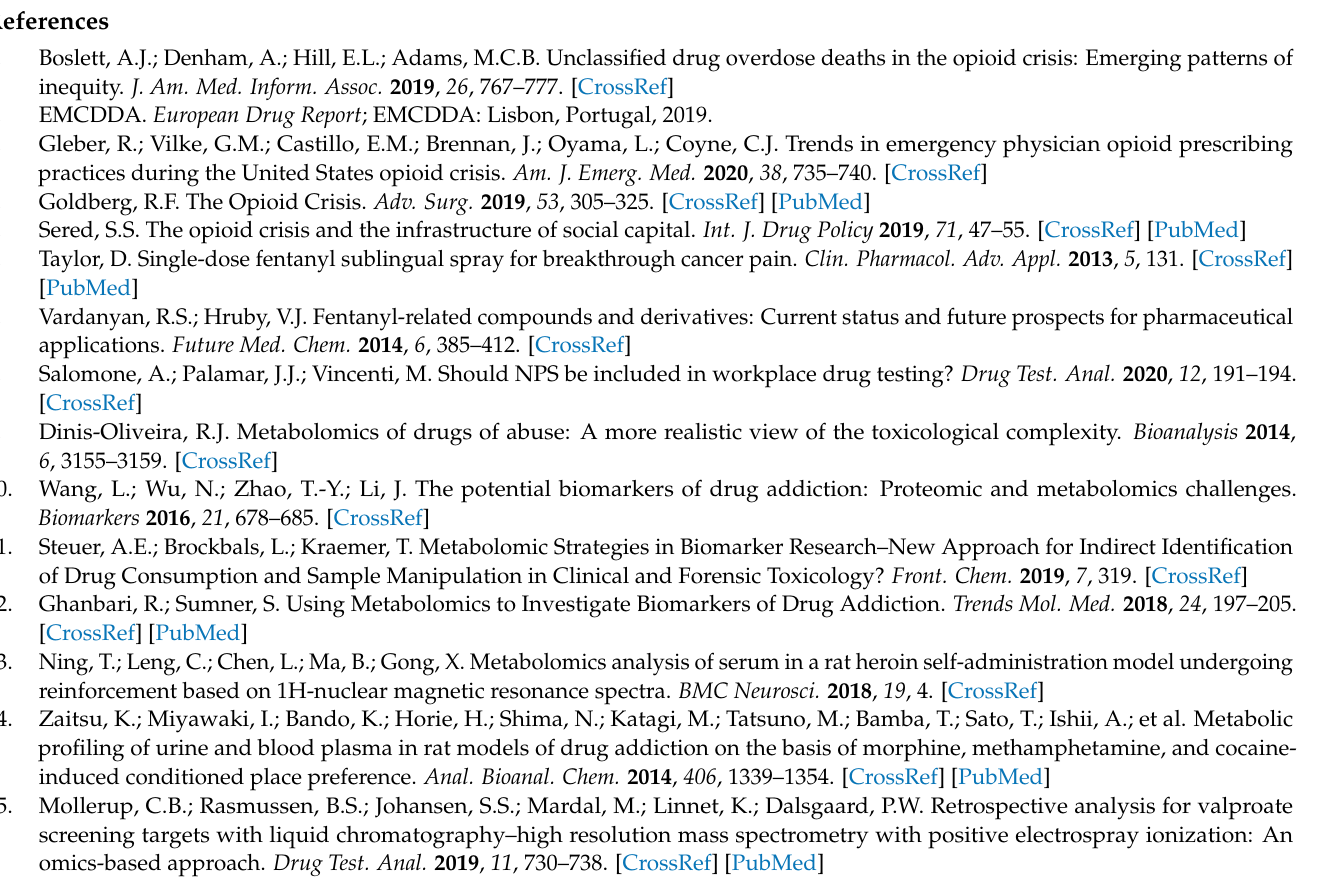
HILIC (B) dataset, respectively, Figure S8: PC2 vs PC4 loadings plot of the PCA model built with the RP dataset. The loadings are coloured on the basis of the retention time: (A) lower than (or equal to) 1 min, (B) between 1 min and 3 min, (C) between 3 min and 5 min, and (D) higher than 5 min, Table S1: Fentanyl and norfentanyl dosage. The method’s limit of detection is equal to 0.2